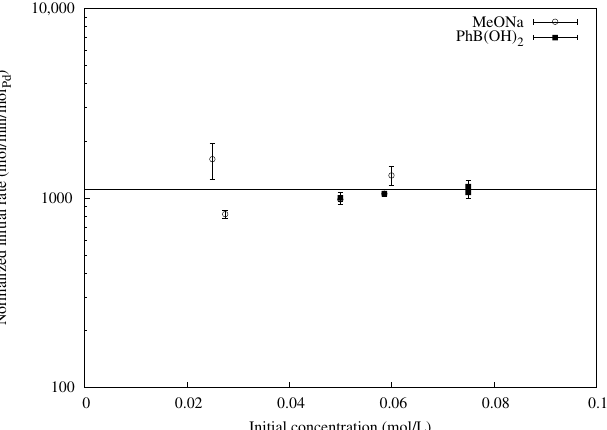
Figure 4. Effect of the initial concentration of sodium methylate and phenylboronic acid on the reaction rate. The initial rates (logarithmic plot) are normalized by the mass of Pd. Conditions: 4-iodoacetophenone (0.05 mol/L), phenylboronic acid (from 0.03 to 0.15 mol/L), MeONa (from 0.035 to 0.15 mol/L), Pd (5 · 10 − 6 mol/L), ethanol (20 mL), and 60 ◦